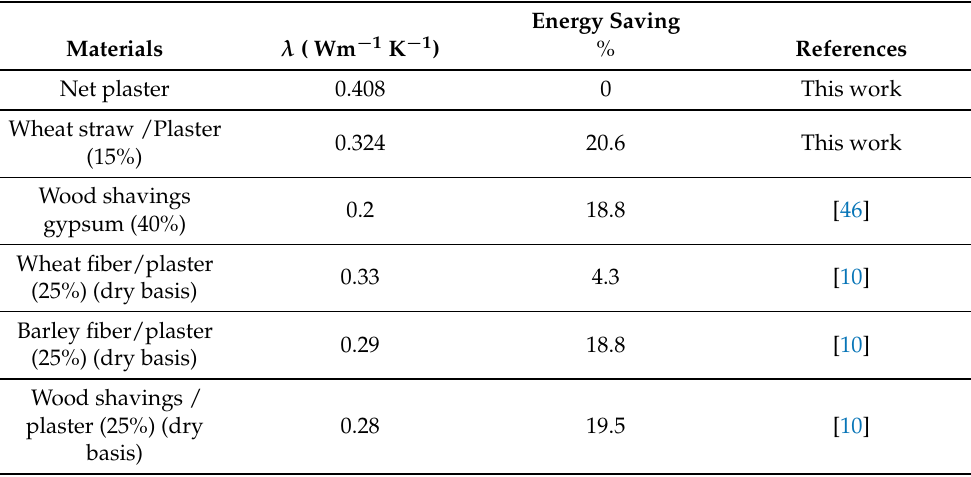
Table 3. Wheat straw/plaster composite compares to other construction materials in terms of thermal conductivity and energy